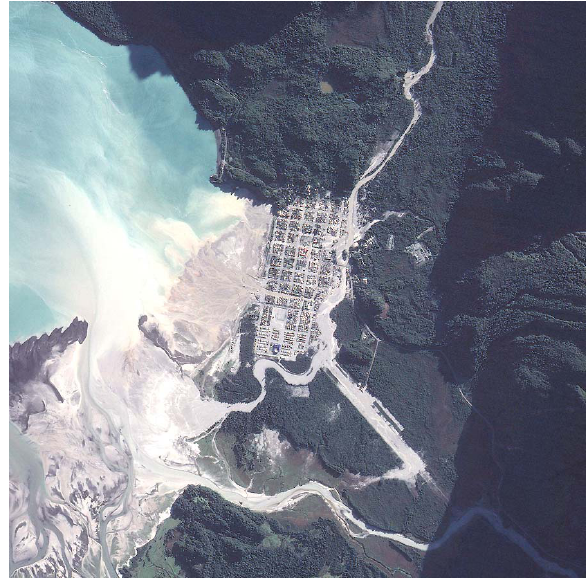
(A) Satellite view showing the inundation of the town of Chaitén by lahars and Fig. 12a. Satellite view showing the inundation of the town of floods as well as the suspended sediment offshore [Lara, 2009, Fig. 4A, image Chait´en by lahars and floods as well as the suspended sediment offshore (Lara, 2009, Fig. 4a, image courtesy of NASA http:// courtesy of NASA <http://earthobservatory.nasa.gov>]. earthobservatory.nasa.gov).